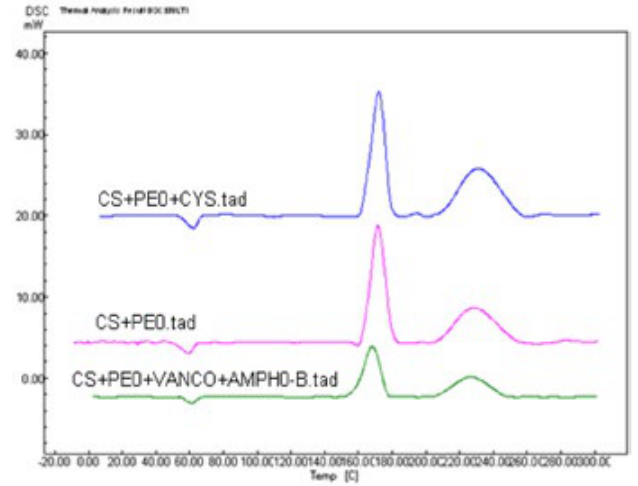
FIGURE 4 - DSC thermograms of CS/PEO, CS/PEO/Cys, CS/ PEO/Cys/ Drugs.